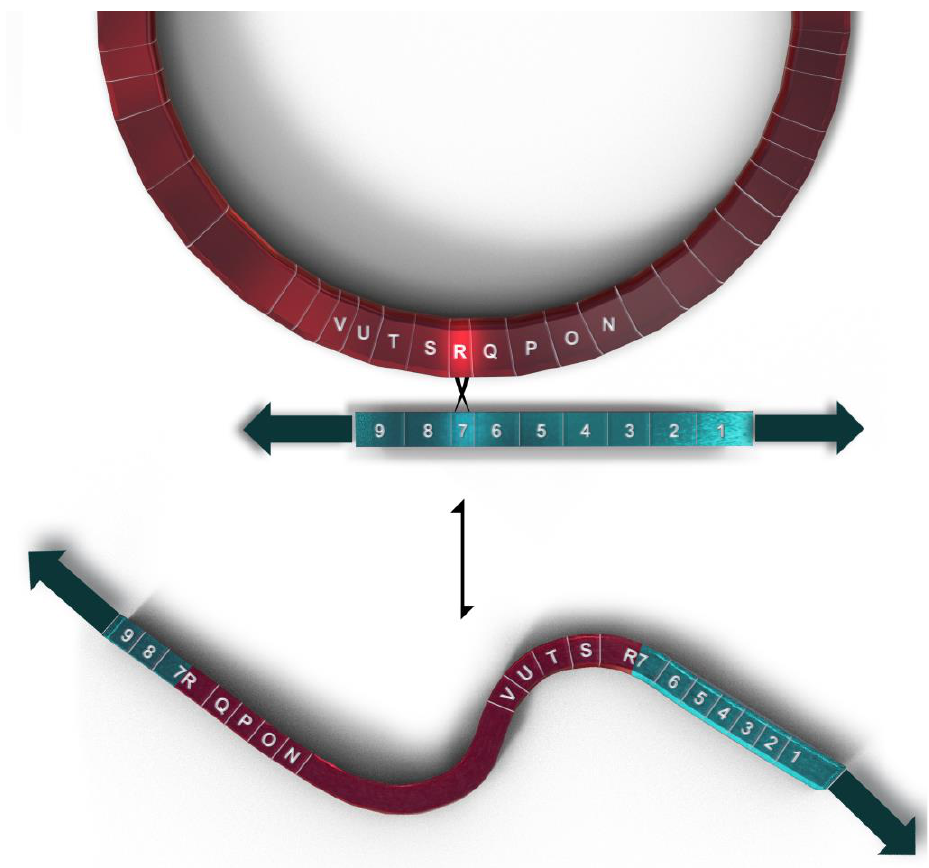
RS indicates the potential recombination site with the mtDNA.